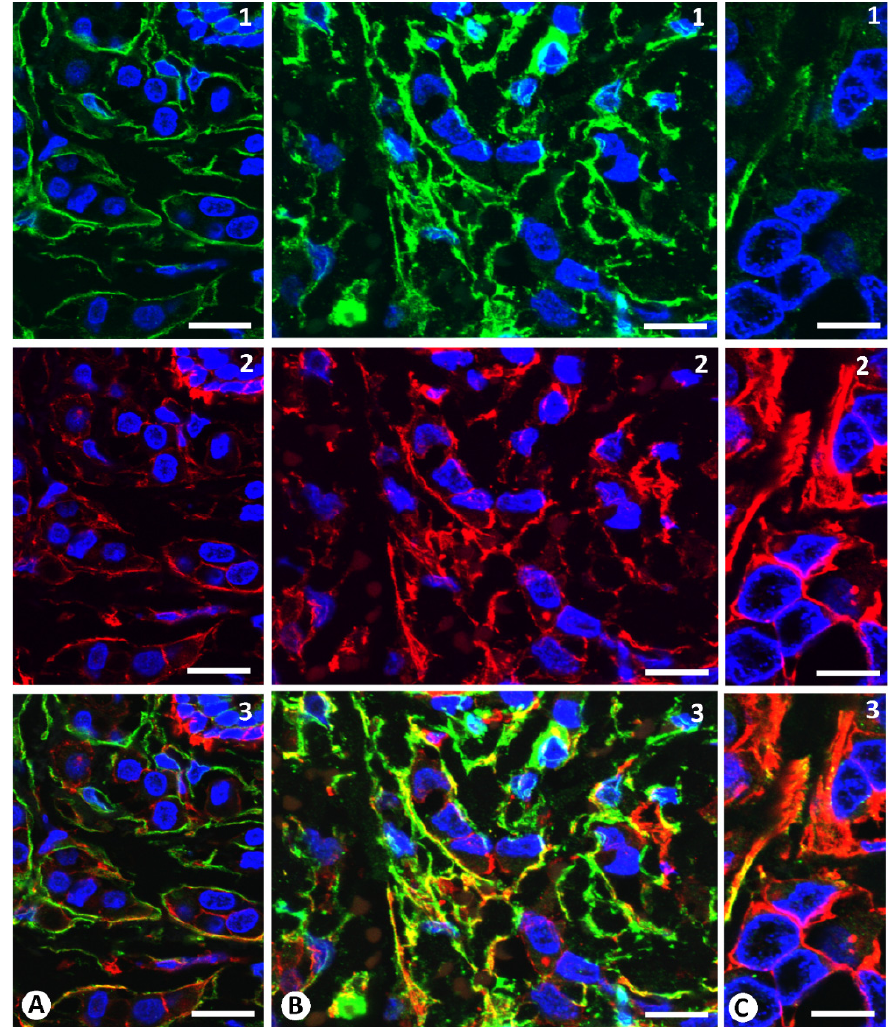
Figure 10. Double immunofluorescence labelling for CD34 (green) and α SMA (red) with DAPI (blue) counterstain. Numerous cells expressing both markers are observed where CD34+SCs predominate ( A ) or where there is a balanced proportion of CD34+ and α SMA+ stromal cells ( B ) rather than where α SMA+ stromal cells predominate ( C ). Numbers indicate the expression of CD34 ( 1 ), α SMA ( 2 ) and merged expression of CD34 and α SMA ( 3 ). Bar: ( A – C ): 20 µm.